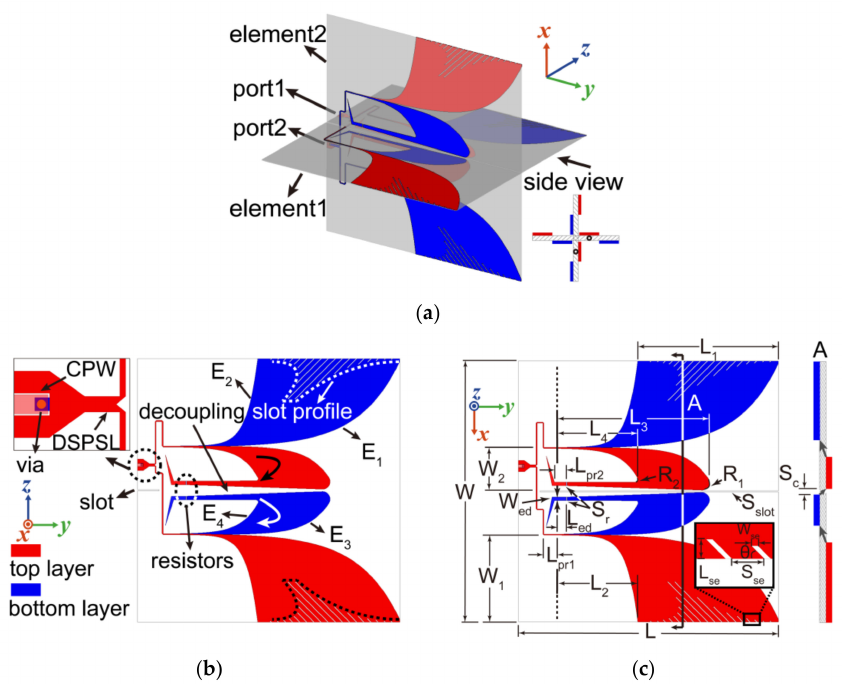
Figure 1. The structure of the proposed DP-DSATSA. ( a ) The total cross-shaped structure; ( b ) the main parts of Element 1; ( c ) the dimension diagram of Element 2.